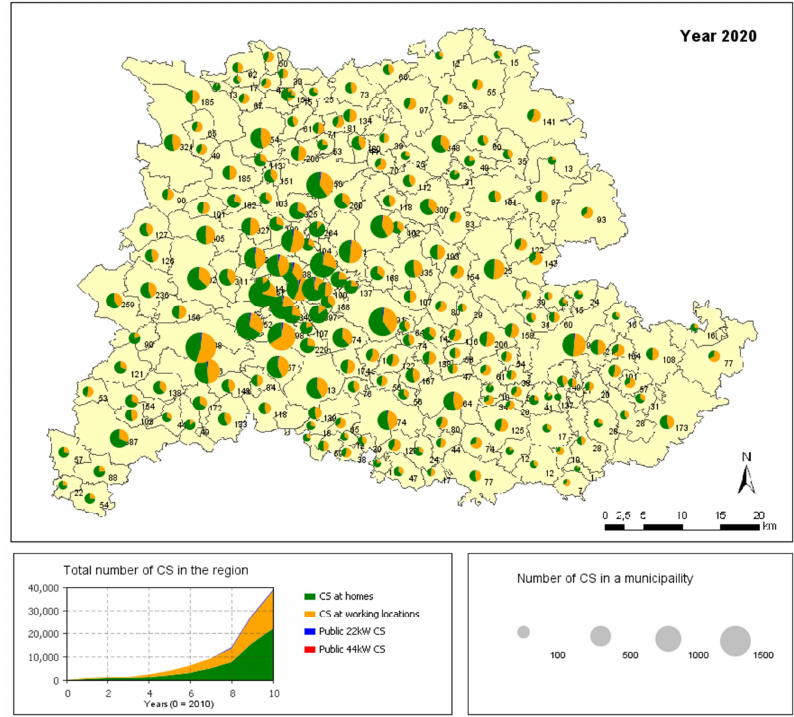
Figure 8. Development of charging infrastructure until 2020 in the baseline scenario